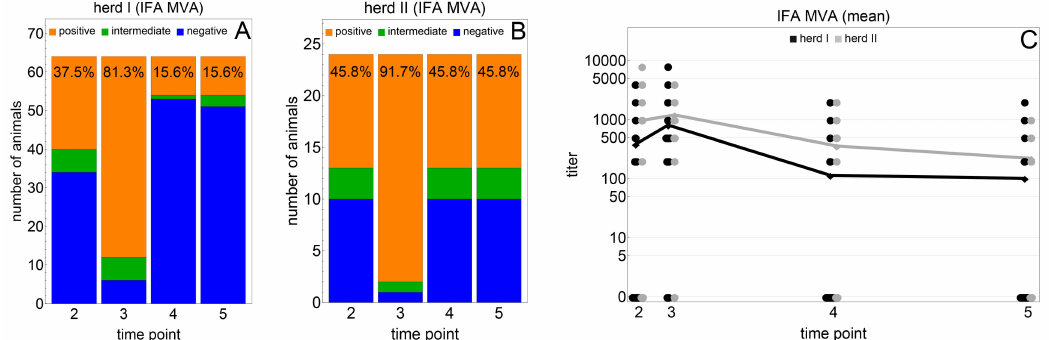
Figure 1. Field trial vaccination against cowpox in two alpaca herds in Germany: Results of indirect immunofluorescence assay (IFA) after immunisation with the MVA (modified vaccinia virus Ankara) vaccine in herd I ( A ) and herd II ( B ) and the distribution of MVA-specific IFA titres and mean titres by herd and time point ( C ). Herd I—Thuringia ( n = 64); Herd II—Saxony Anhalt ( n = 24); time point 2—four weeks after initial vaccination, time point 3—four weeks after booster vaccination, time point 4—six months after booster vaccination, time point 5—12 months after booster vaccination; solid dots / short horizontal lines—individual titres (Figure 1C); solid lines—mean titres (Figure